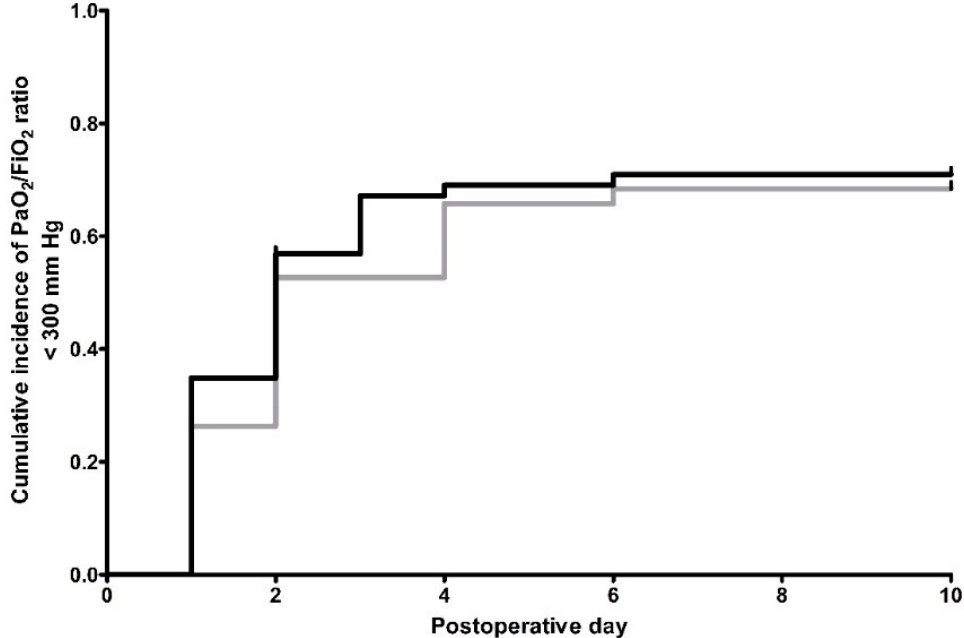
Figure 2. Kaplan-Meier estimation of PaO 2 / FiO 2 < 300 mm Hg, indicating respiratory impairment. Black line: conventional open abdomino-thoracic esophagectomy (OE)-group, n = 105 patients. Gray line: hybrid minimally invasive, laparoscopically assisted abdomino-thoracic esophagectomy (LAE)- group, n = 38 patients. Patients, who were discharged, died, or suffered from re-do (revision) surgery were censored from the analysis of cumulative incidences since the day of the event. Censored data are indicated in the figures by vertical ticks. An PaO 2 /FiO 2 of <300 mm Hg on postoperative day 0 (arrival on intensive care unit) was not judged as postoperative event.